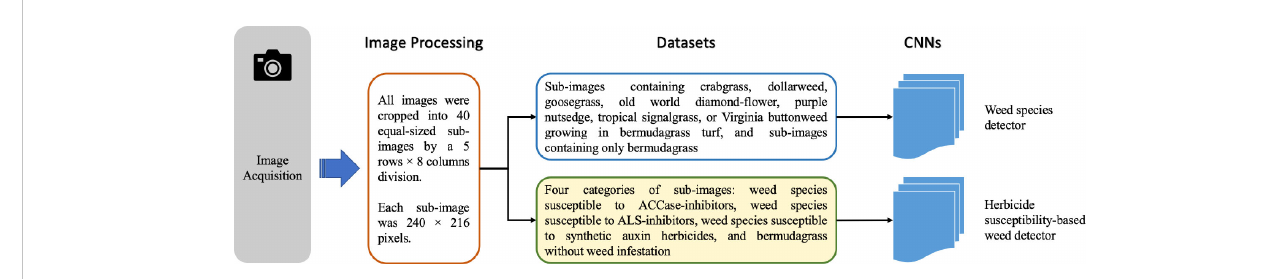
FIGURE 5 Flow diagram illustrates the sequence of image processing and training and testing the convolutional neural